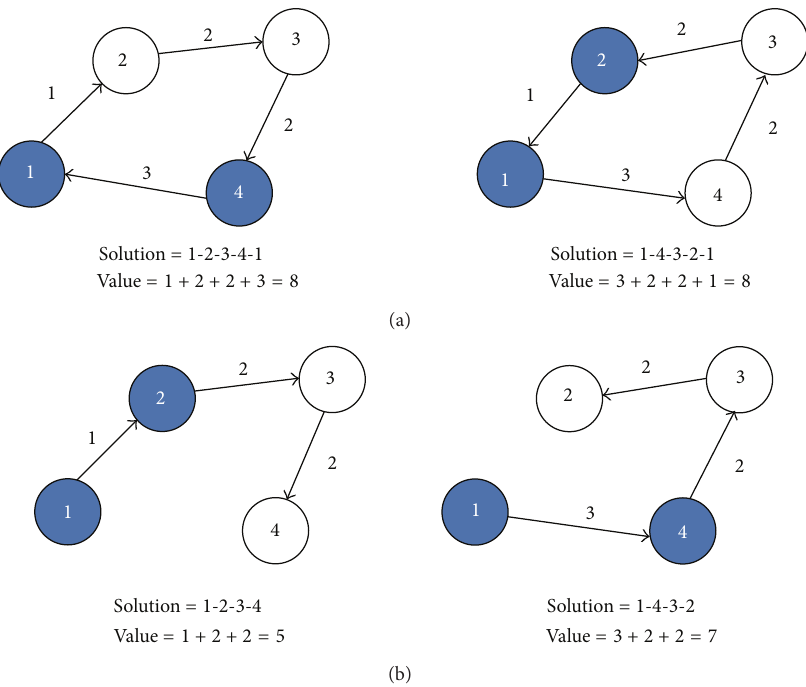
Figure 4: The two possible CVRP and OVRP